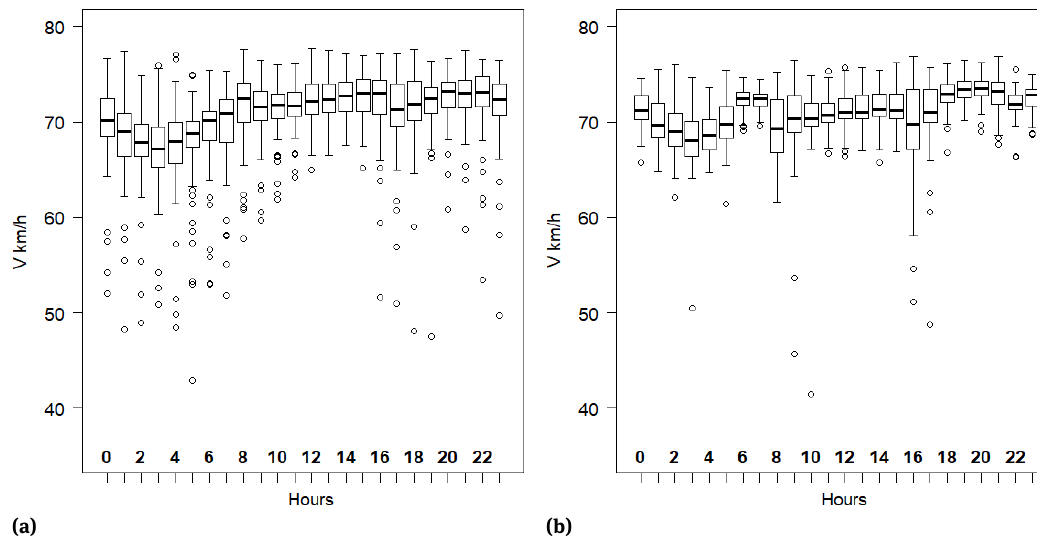
Figure 7: Annual hourly traflc velocity box plots at business day a) in 2012, b) in 2016